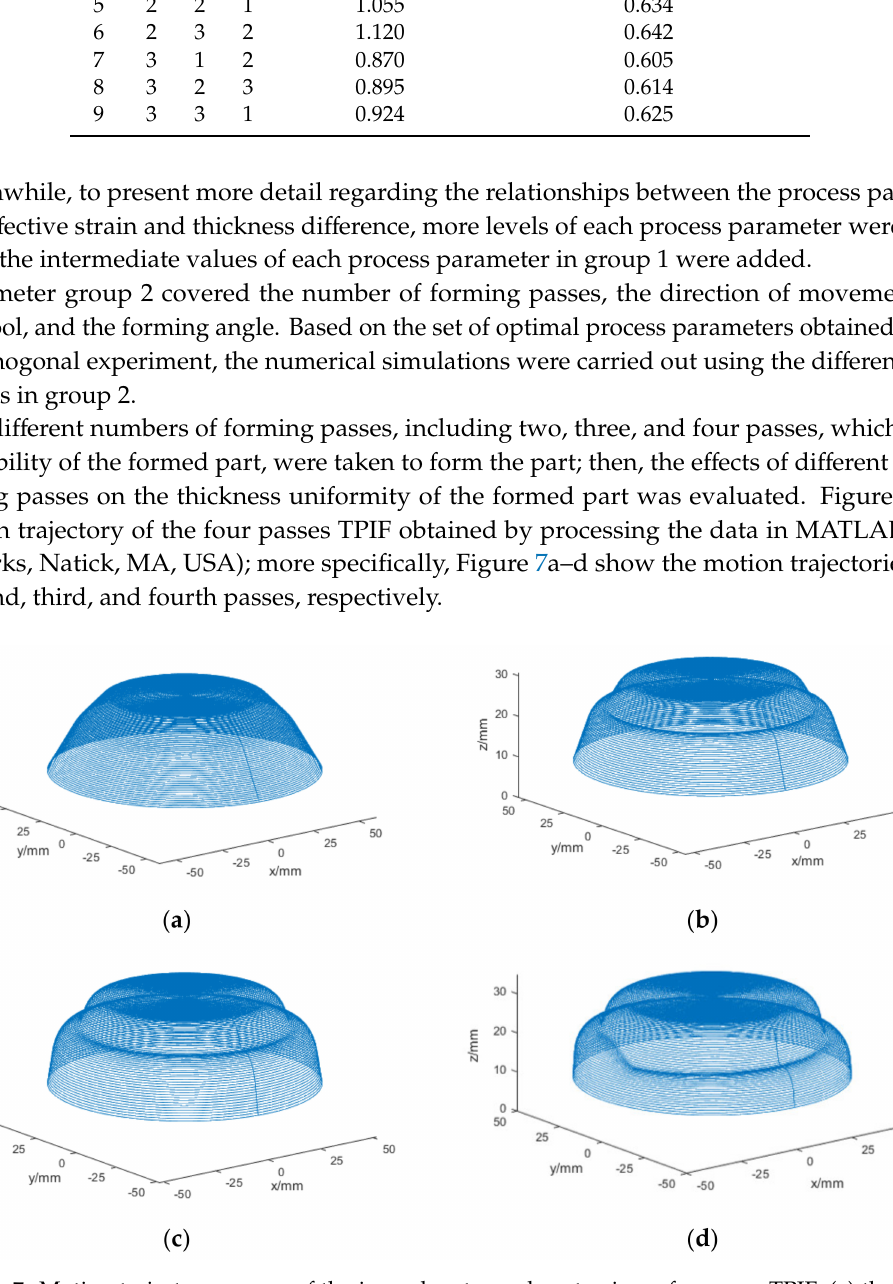
Figure 7. Motion trajectory curves of the irregular stepped part using a four-pass TPIF: ( a ) the first pass, ( b ) the second pass, ( c ) the third pass, and ( d ) the fourth